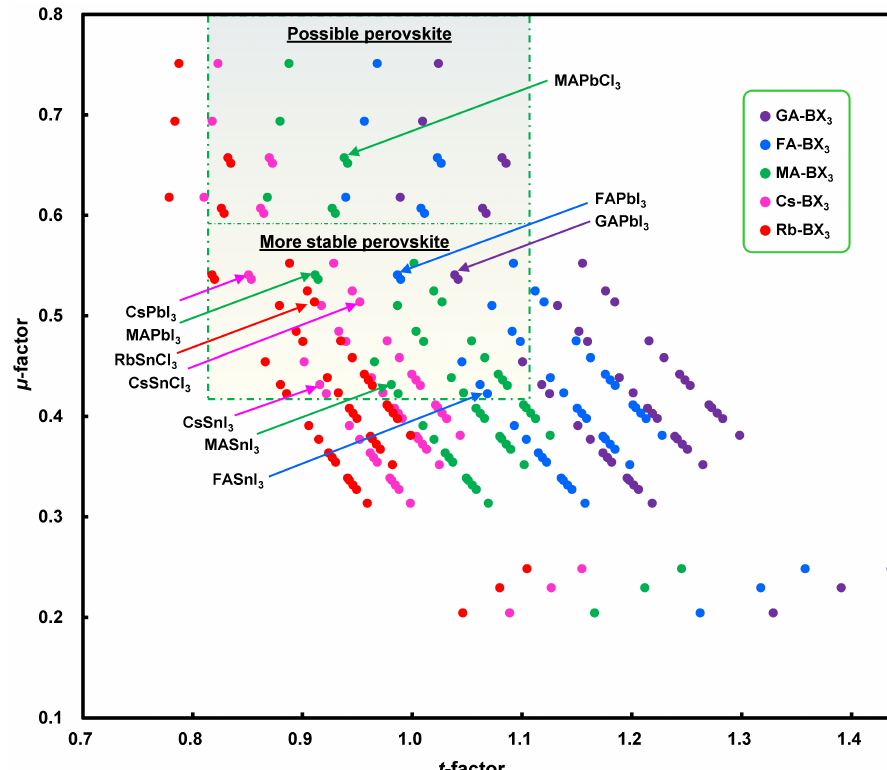
Figure 5: The t - and µ -factors of ABX 3 perovskite